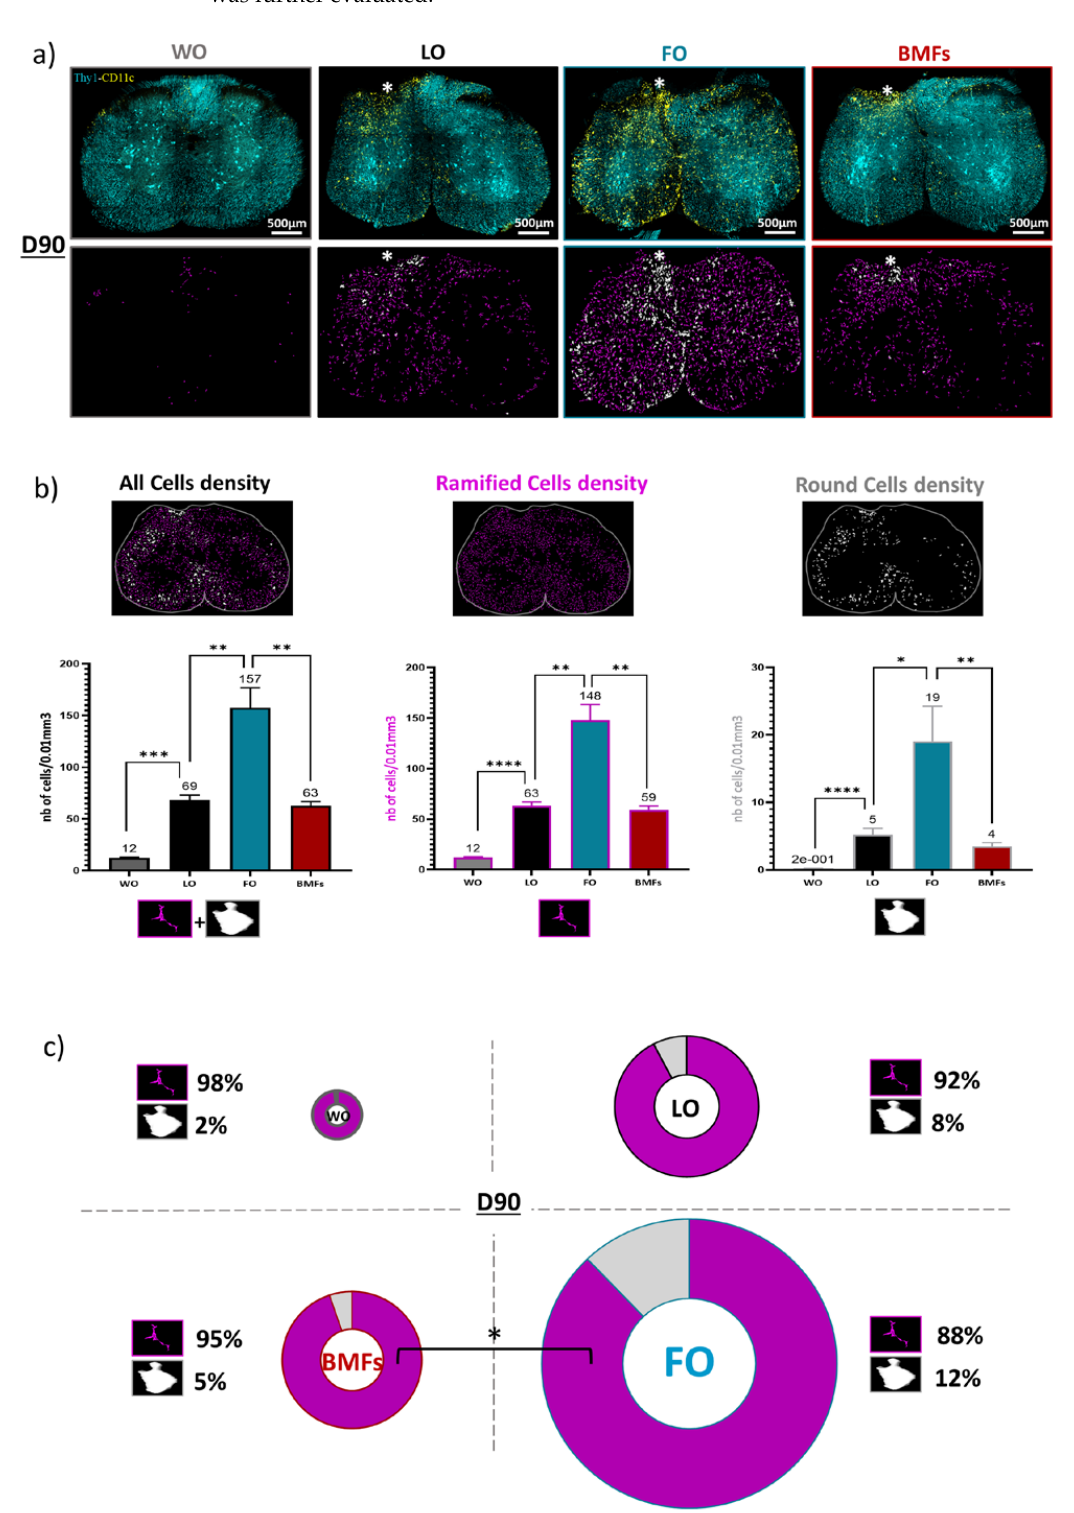
Figure 5. Quantification of chronic inflammation ninety days after lesion ( a ) Representative confocal (top) and related segmented (bottom) images for coronal spinal cord section obtained on D90